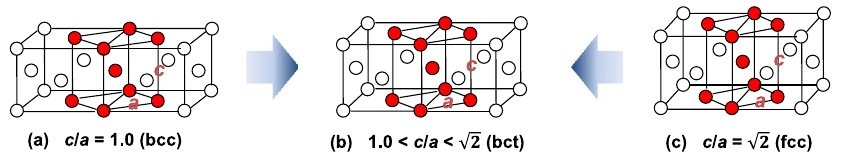
Figure 1. Schematic images of ( a ) bcc, ( b ) bct, and ( c ) fcc structures (based on the Bain relationship typically observed in martensitic materials).